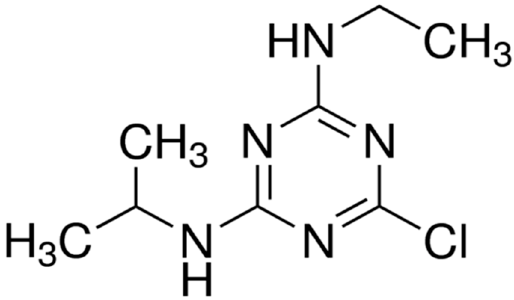
Figure 1. Structure of the atrazine (ATZ) herbicide.